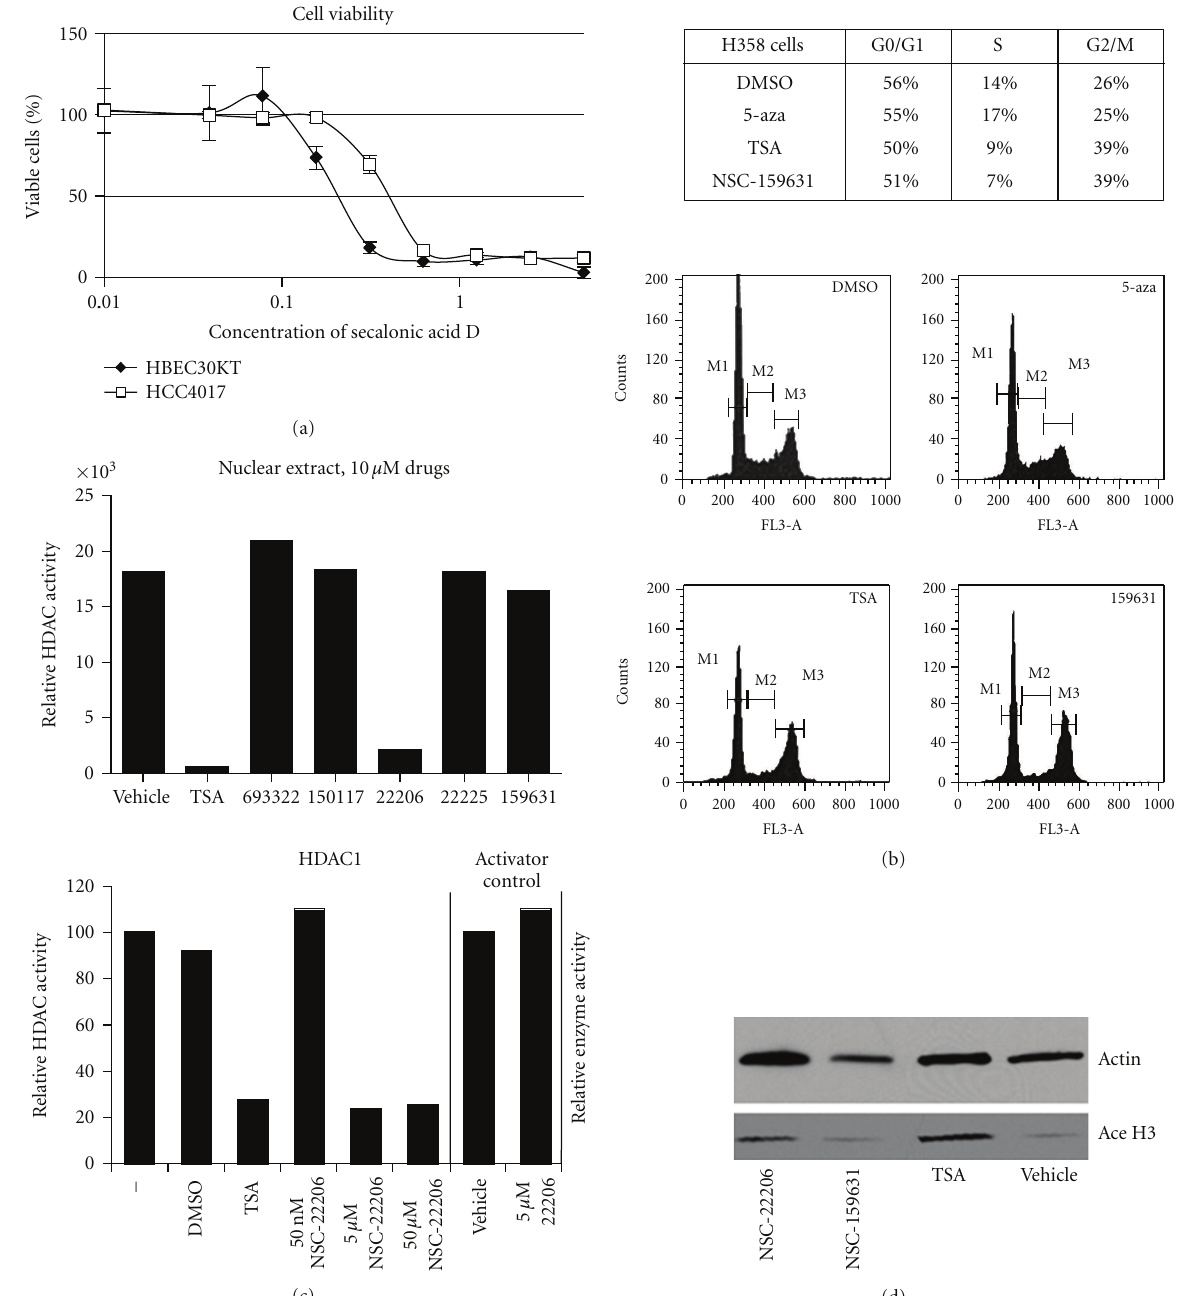
Figure 6: Characterization of LDR assay hits. (a) MTS Assay was performed with increasing doses of Secalonic acid D on a matched pair of lung cells: the lung cancer line HCC4017 and the normal line HBEC30KT. Secalonic acid D did not show selectivity for cancer. (b) Cells were treated with vehicle or drug and sorted by cell-cycle phase after propidium iodide staining. TSA (200nM) and NSC-15931 (5 µ M) both caused cells to accumulate in G2/M phase as compared to vehicle or 5-azadeoxycytidine (1 µ M). Values do not add to 100% because of the small fraction of sub G0/G1 cells. (c) In vitro HDAC activity assays were performed on nuclear extracts treated with 10uM hit compounds (left panel). Purified active HDAC1 activity was assayed in the presence of increasing concentrations of NSC-22206, which inhibited HDAC1 (right panel) but did not inhibit the coupled reaction (right side of panel).” (d) H358 lung cancer cells were treated with drugs for 24 h and analyzed by Western Blot for changes in global histone modifications. NSC-22206 (10 µ M) and TSA (200nM) both caused an increase in levels of acetylated histone 3 whereas NSC-159631 (0.5 µ M) did